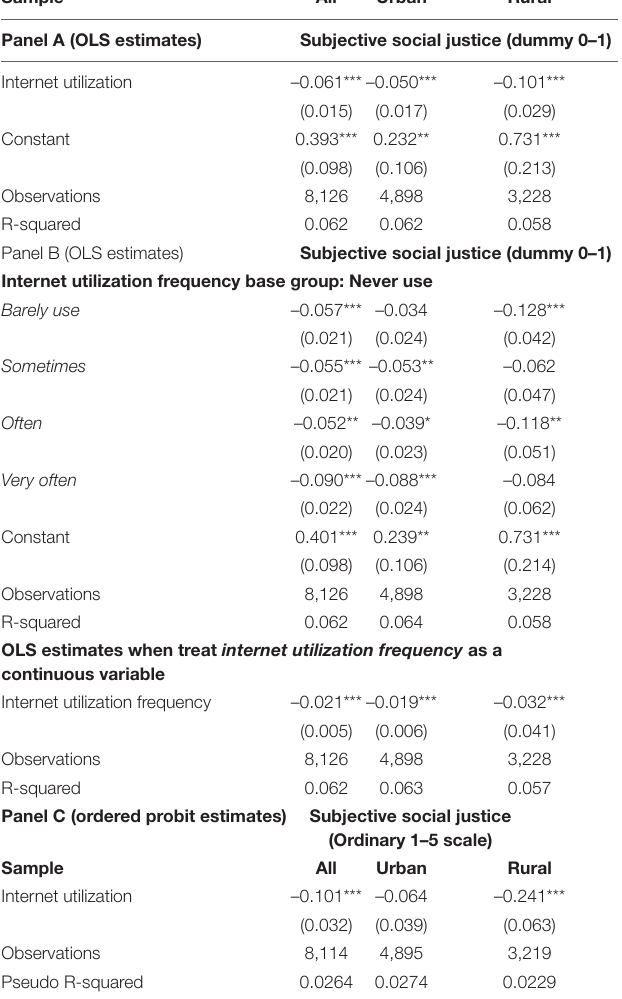
TABLE 6 | Robustness check with 2010 CGSS.